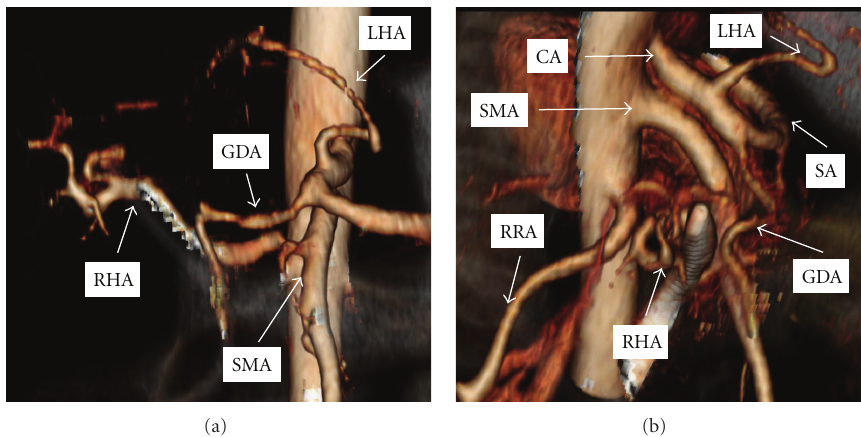
Figure 1: Coronal (a) and lateral (b) computed tomography reconstruction of mesenteric arterial vasculature in Case 1. Structure overlying right hepatic artery represents common bile duct stent. GDA: gastroduodenal artery, LHA: left hepatic artery, RHA: right hepatic artery,